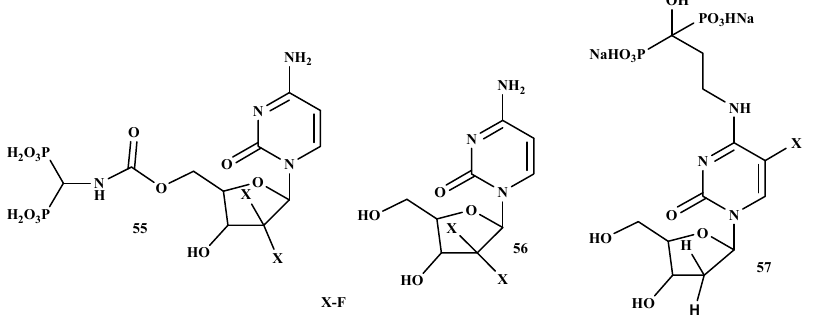
Figure 12. Structures of promising BP ‐ conjugates with anti ‐ lung cancer activity 55–57.